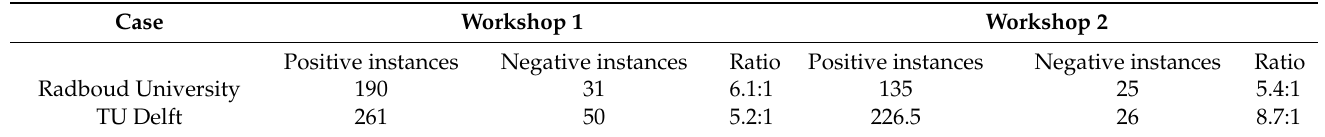
Table 7. Sum of positive and negative instances, comparing cases and workshops (see Appendix B for details).